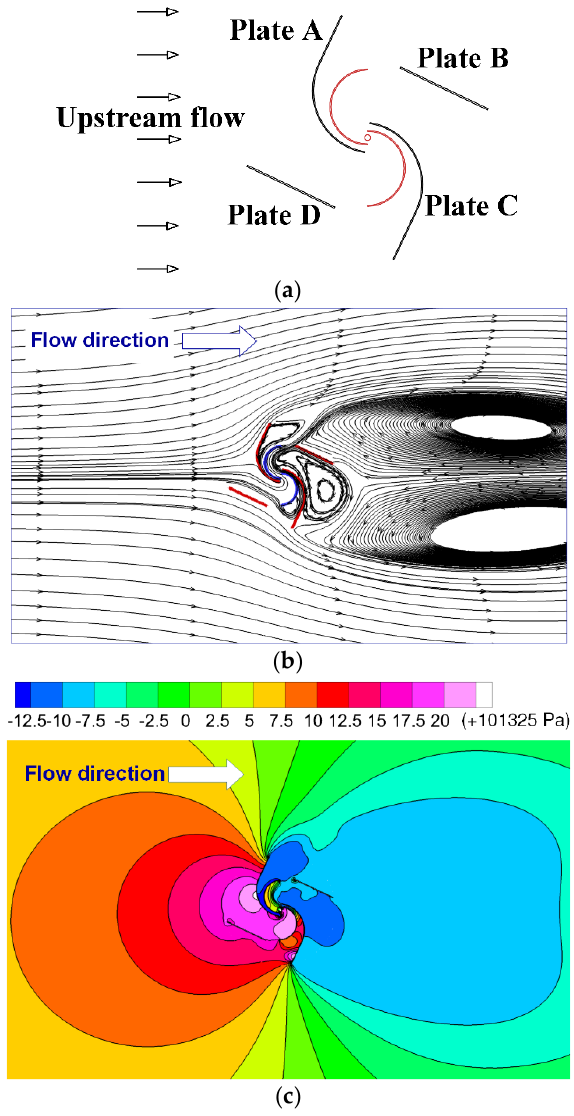
Figure 7. Scheme of asymmetrically arranged auxiliary plates. ( a ) Sketch of the multiple-plate scheme [34]; ( b ) Streamlines; ( c ) Pressure distribution.